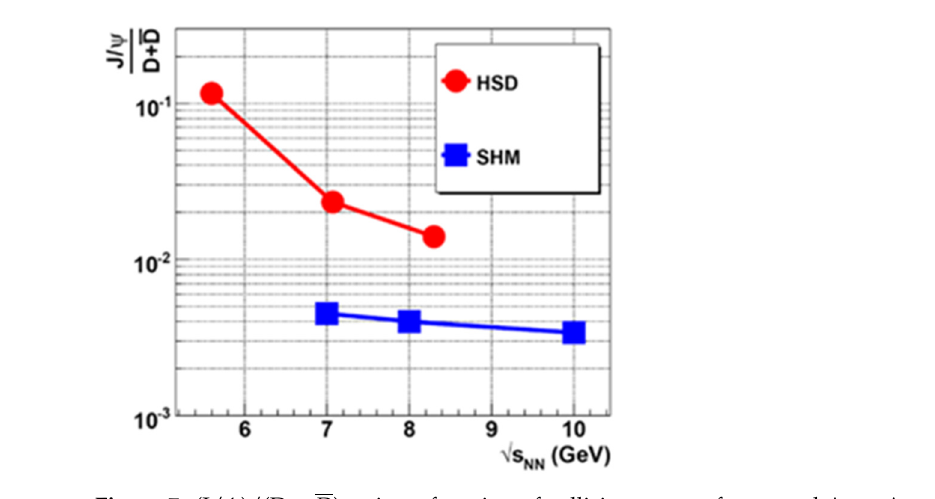
Figure 7. (J/ ψ )/(D + D ) ratio as function of collision energy for central Au + Au reactions. Blue symbols: SHM code [37]. Red symbols: HSD model [38].